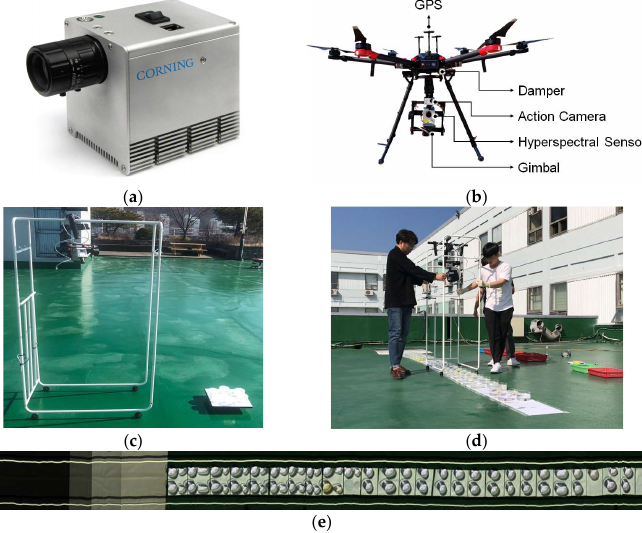
Figure 1. Hyperspectral image sensor and its ground-based outdoor portable holder to obtain spectral images for various hazardous chemicals. ( a ) Hyperspectral sensor used for building spectral image; ( b ) a drone system with hyperspectral sensor, GPS and gimbal supposed to monitor hazardous chemicals in riverine environments; ( c ) a portable holder mounted with hyperspectral sensor on the ground and chemical samples to be photographed; ( d ) manual mobile operation of the portable holder on top of biker containing chemicals; ( e ) resultant hyperspectral image where prepared samples of hazardous chemical were monitored concurrently.